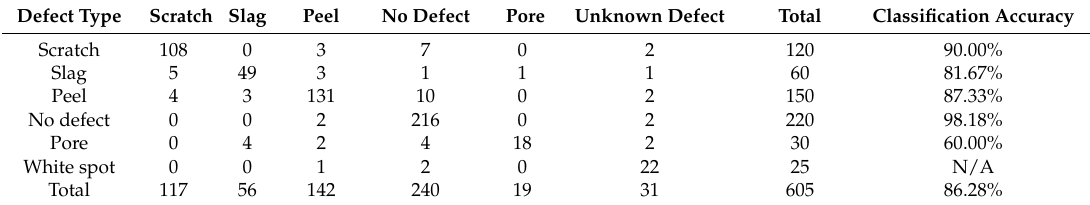
Table 11. Confusion matrix with new samples of the defect type “white spot”.